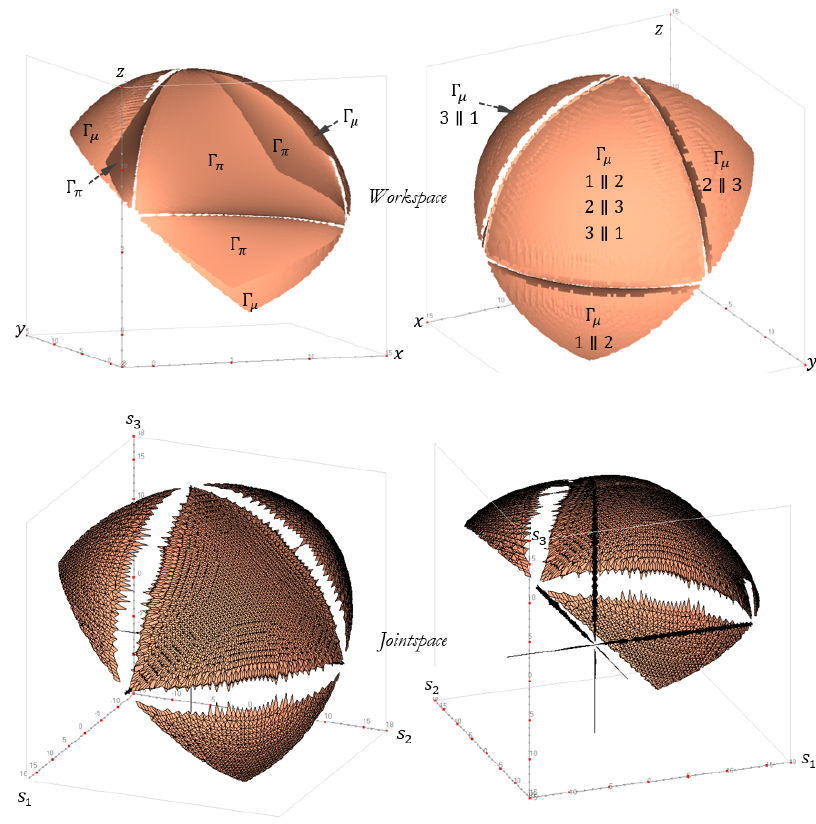
Figure 15. Direct singularity locus in the real workspace and correspondence with the joint-space.